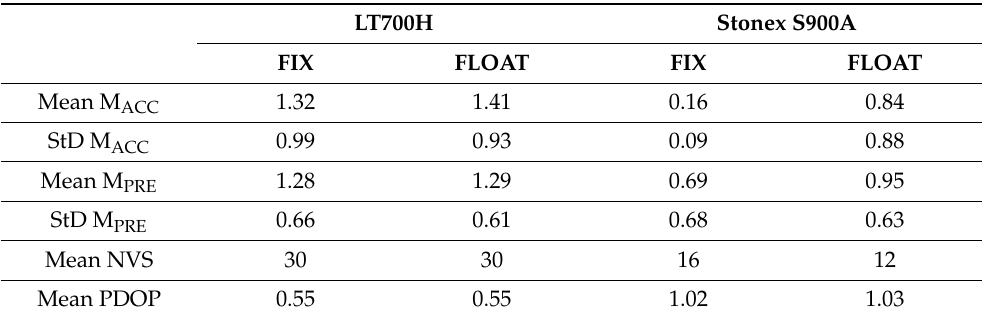
Table 2. Results of the field measurements by the LT700H and Stonex S900A receivers depending on the operating mode. LT700H Stonex